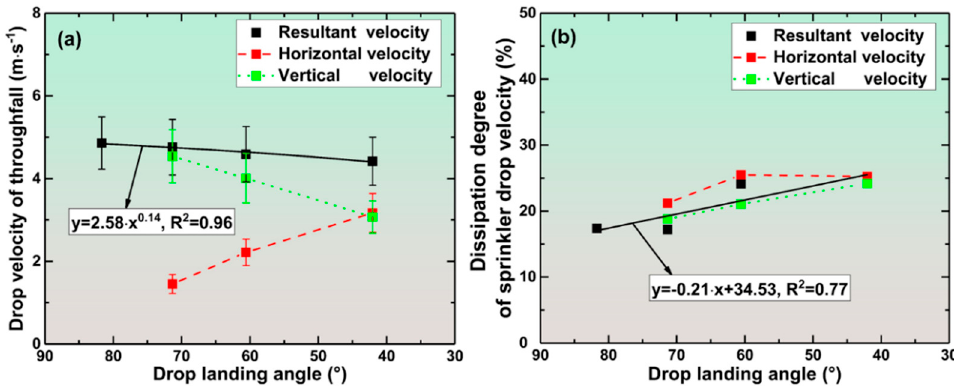
Figure 11. Relationship between the sprinkler irrigation droplets landing angle and velocity of throughfall droplets. When the sprinkler irrigation droplet landing angle is 81.69°, the difference with natural rainfall is not significant [2], therefore, droplet’s equivalent velocities in horizontal and vertical direction are not calculated, respectively. ( a ) the relationship between droplet velocity of throughfall and the landing angel of sprinkler droplets. ( b ) the relationship between dissipation degree of velocity and the landing angel of sprinkler